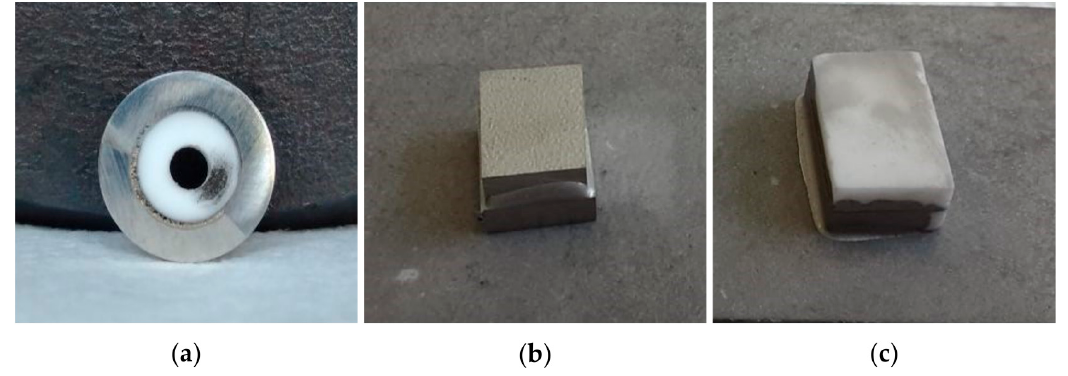
Figure 6. Macrographs of the as-joined samples produced at 900 °C for 12 min in a high-vacuum furnace and 750 °C for 20 min: ( a ) circular configuration, ( b ) H-C22/H-C22, and ( c ) alumina/alu- mina planar configurations.